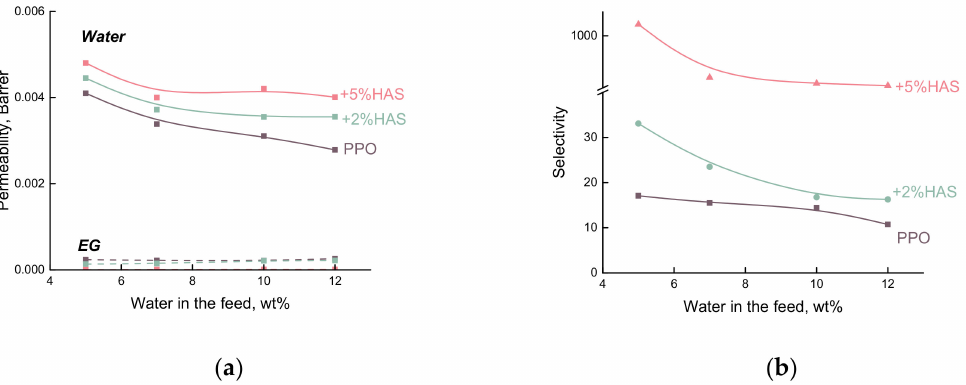
Figure 6. Dependence of ( a ) water and EG permeability and ( b ) selectivity ( α water / EG ) on water concentration in the feed for the pervaporation of EG / water mixture using the PPO-based membranes, 50 ◦ C.